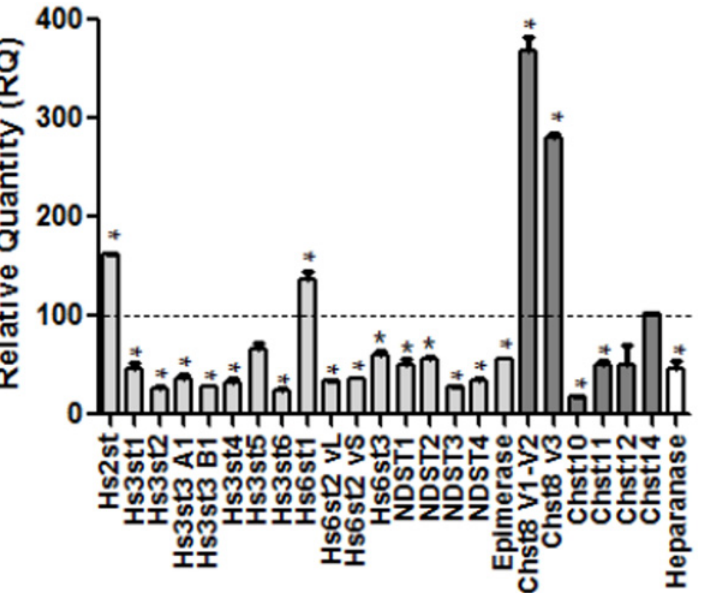
Figure 4. GAGs metabolism in normal and MPP + -stressed cells. Analysis of enzymes involved in GAGs metabolism by Real Time PCR. Real time PCR of Hs2st, Hs3st1, Hs3st2, Hs3st3, Hs3st3A1, Hs3st3B1, Hs3st4, Hs3st5, Hs3st6, Hs6st1, Hs6st2vL, Hs6st2vS, Hs6st3, NDTS1, NDST2, NDST3, NDST4, Chst8 v1 and v2, Chst8 v3, Chst10, Chst11, Chst12, Chst14, epimerase and heparanase were performed with RNA extracts from MPP + -stressed (24 h) and normal cells. Values were normalized using geNorm software, an accurate normalisation of gene expression with multiple references genes [30]. The following reference genes glyceraldehyde 3-phosphate dehydrogenase (GAPDH), glutamine synthetase and alpha-tubulin were used. Each measure is the mean +/- S.E.M. from measurements performed on 3 independent cultures. * p < 0.01 compared to control cells. Light grey bars: HS biosynthesis enzymes; dark grey bars: CS biosynthesis enzymes; white bar: HS degradation enzyme.